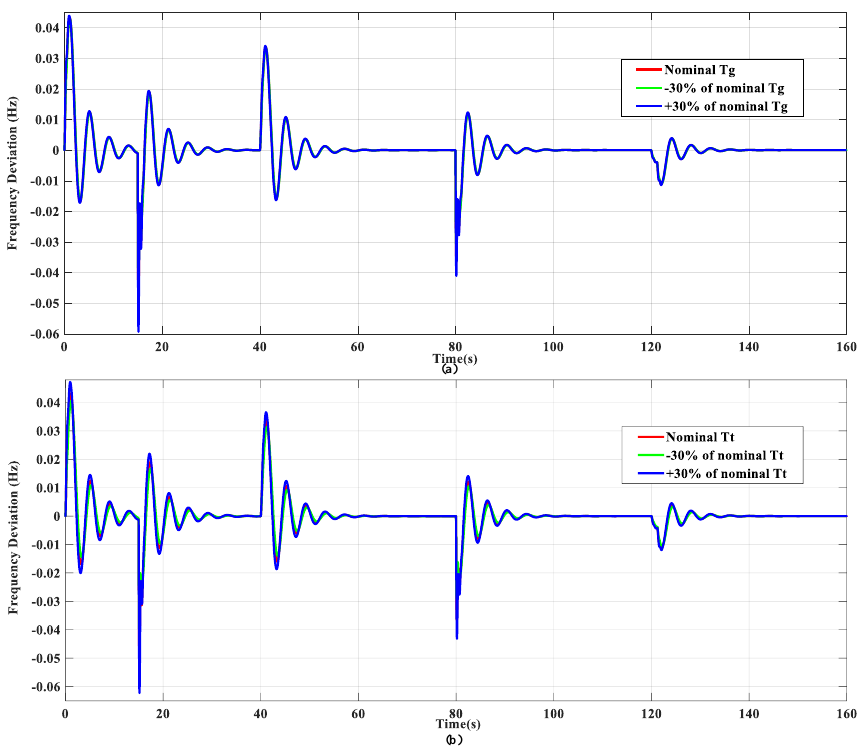
Figure 10. System sensitivity analysis using the presented FOCC controller during ±30% changes in ( a ) T g ( b ) T t . Table 5. Sensitivity analysis for the proposed controller under ±30% changes in Tg and Tt. Controller Parameter MAGFD +30% Proposed FOCC